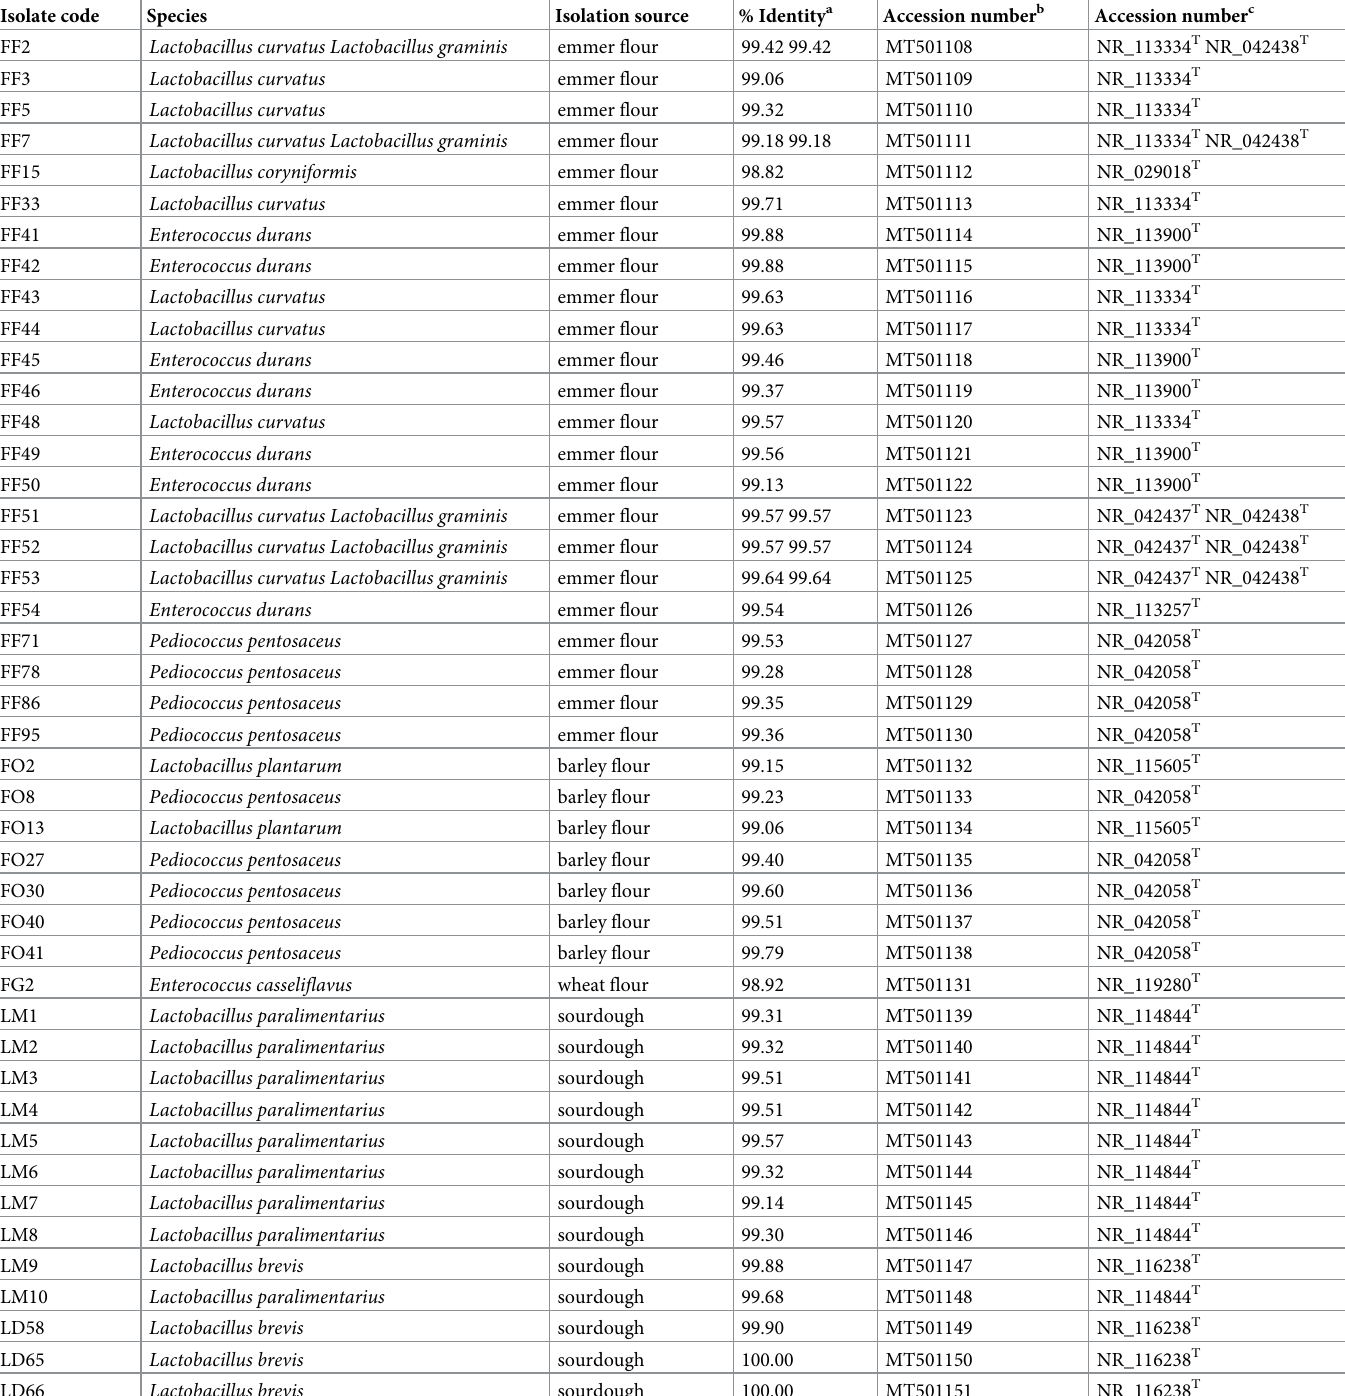
Table 1. 16S rRNA identification of lactic acid bacteria (LAB) isolated in the present study from different flours and sourdoughs. Isolate